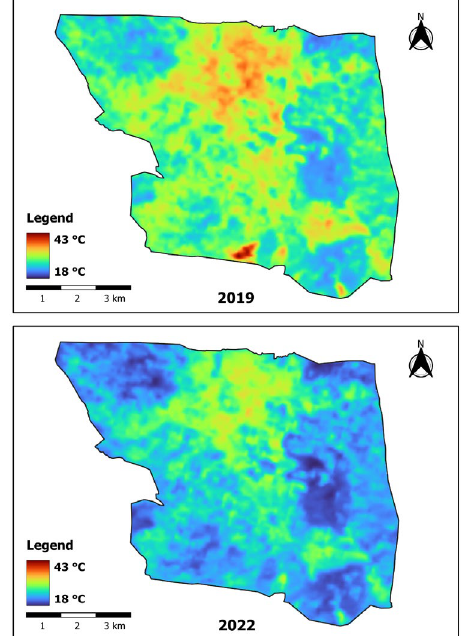
Figure 4. LST distribution in Baguio City on March 25, 2019 and March 09, 2022. The LST values are lower in March 2022 than in March 2019.